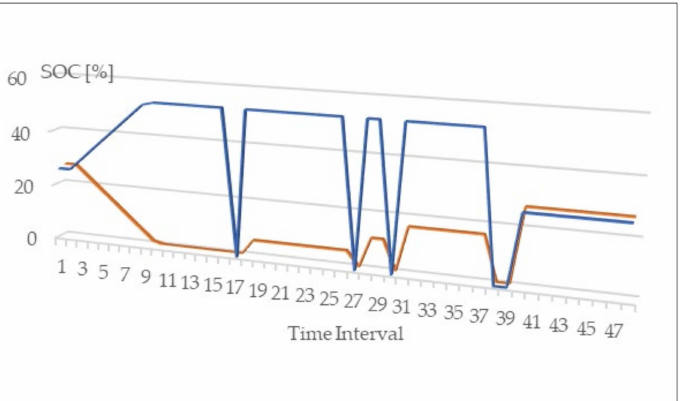
Figure 9. Daily profile of up (blue) and downward (orange) flexibility that the EV can